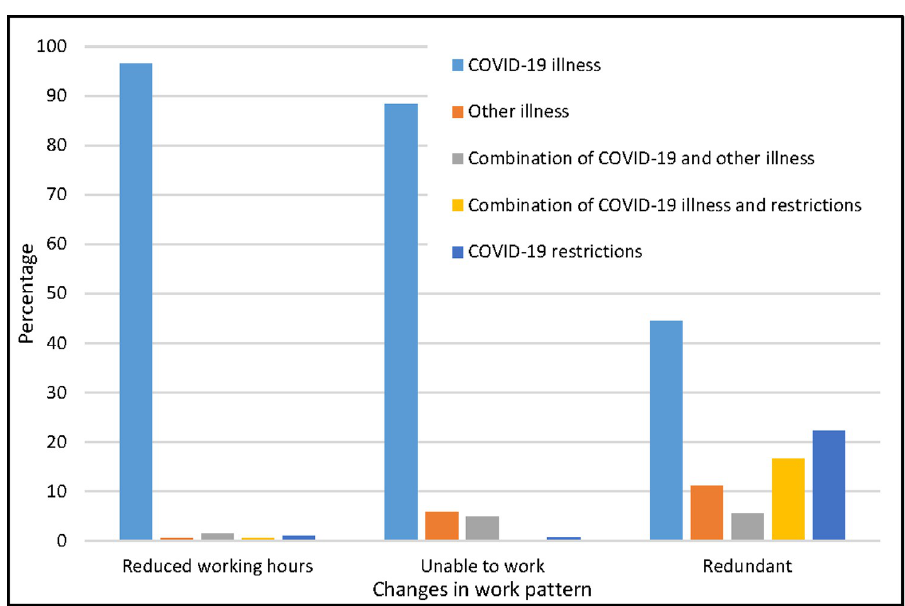
Fig 2. Reasons for change in work pattern in those reporting reduced work hours (n = 243), being unable to work (n = 478) or being made redundant/taking early retirement (n-47) (total n =